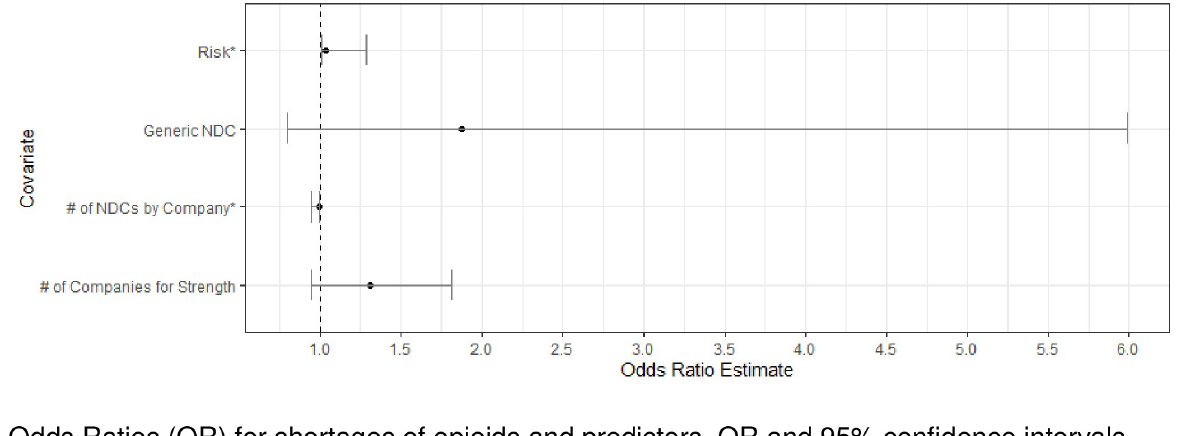
Fig 1. Shortages of opioids: Odds ratios estimates.